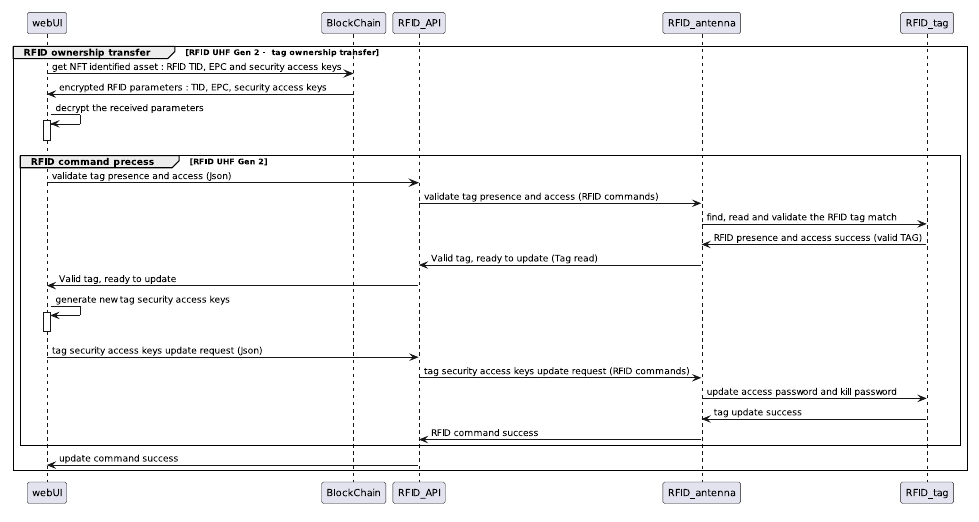
Figure 5. RFID ownership transfer